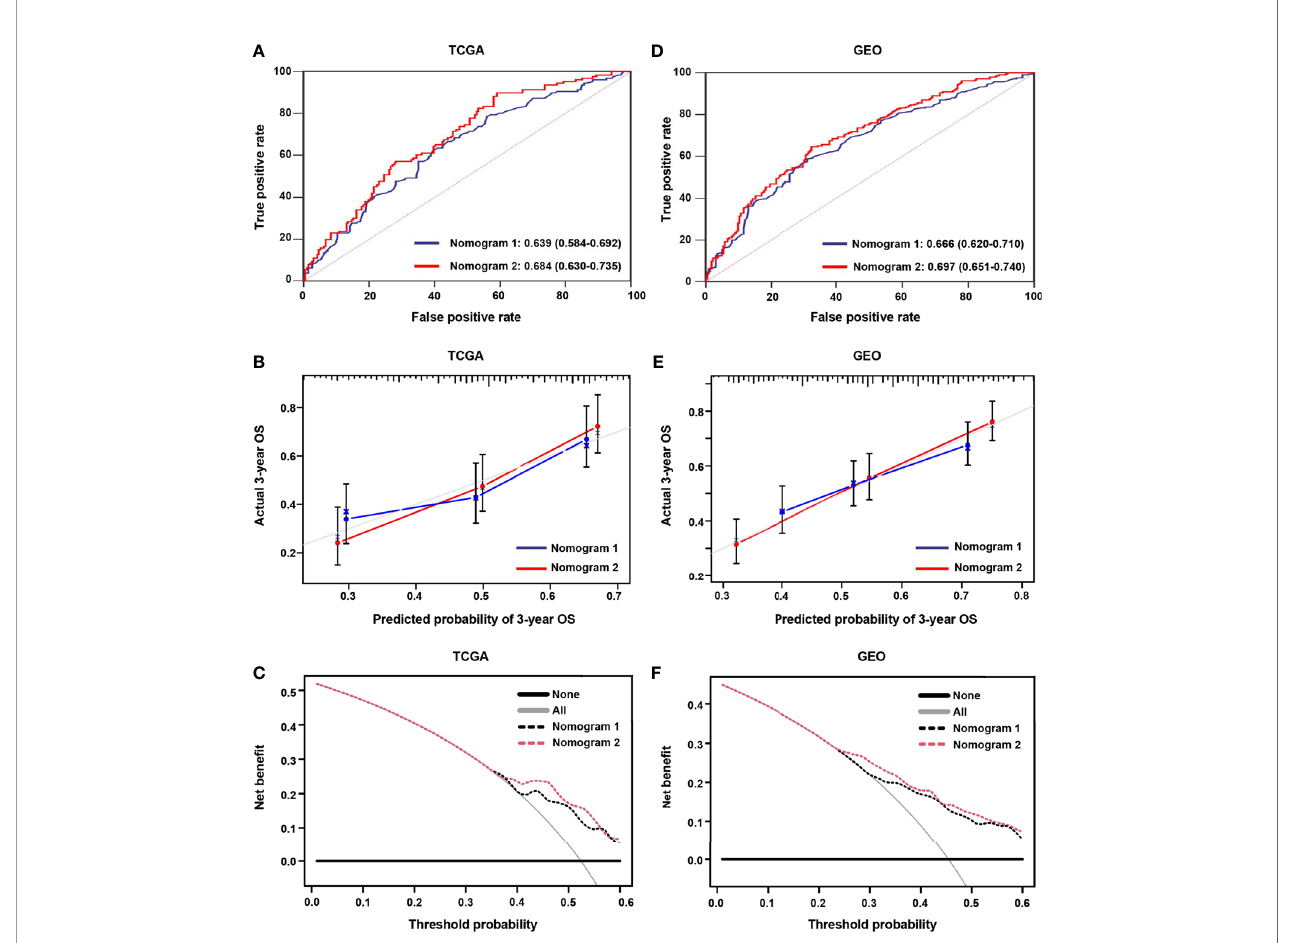
FIGURE 9 | The areas under the curve (AUC), calibration curve and decision curve analysis (DCA) for predicting patient survival. (A, D) The AUCs assess the accuracy of the nomograms in the screening and validation cohorts. (B, E) The calibration curves assess the consistency of the nomograms in the screening and validation cohorts. (C, F) DCAs assess the clinical usefulness of nomograms in the screening and validation